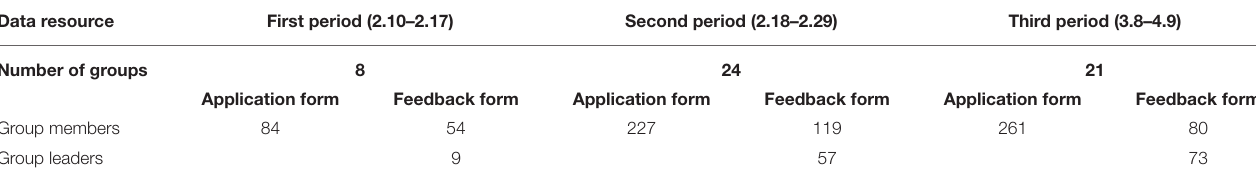
TABLE 1 | Sample and data of the